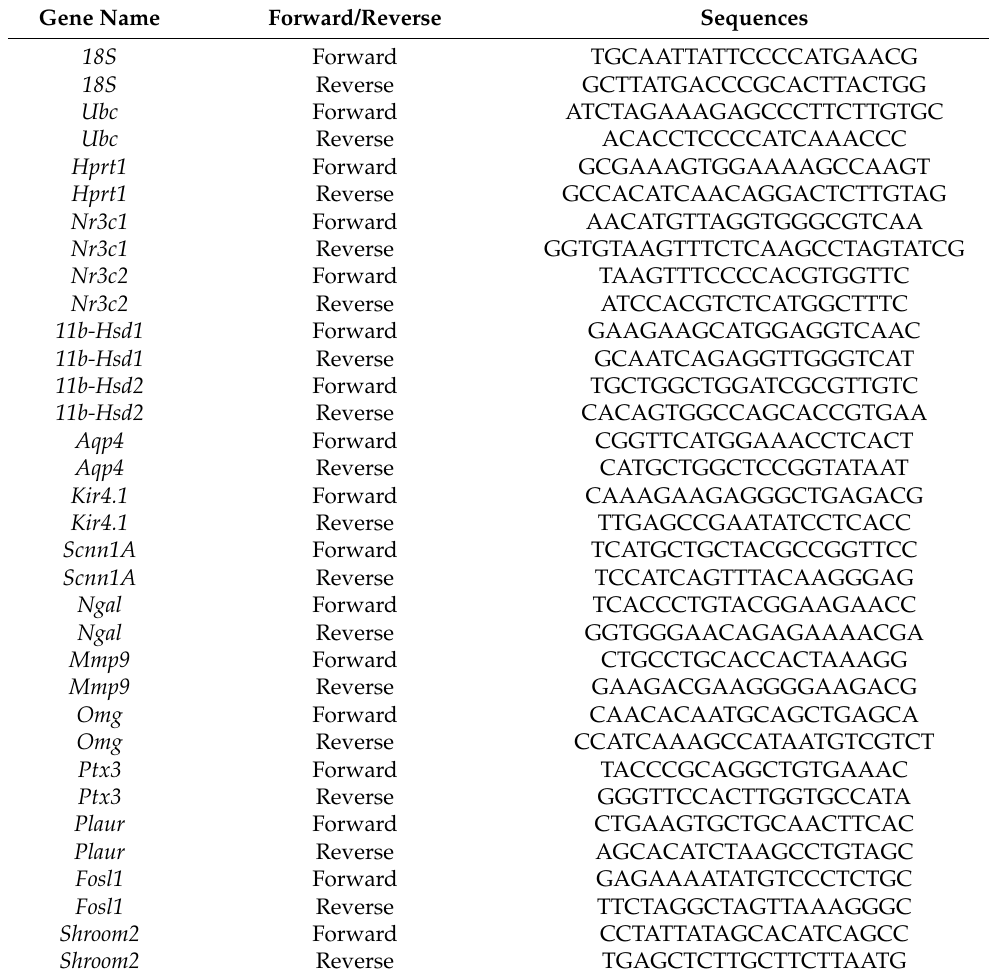
Table 1. Shows the list of primers used in this